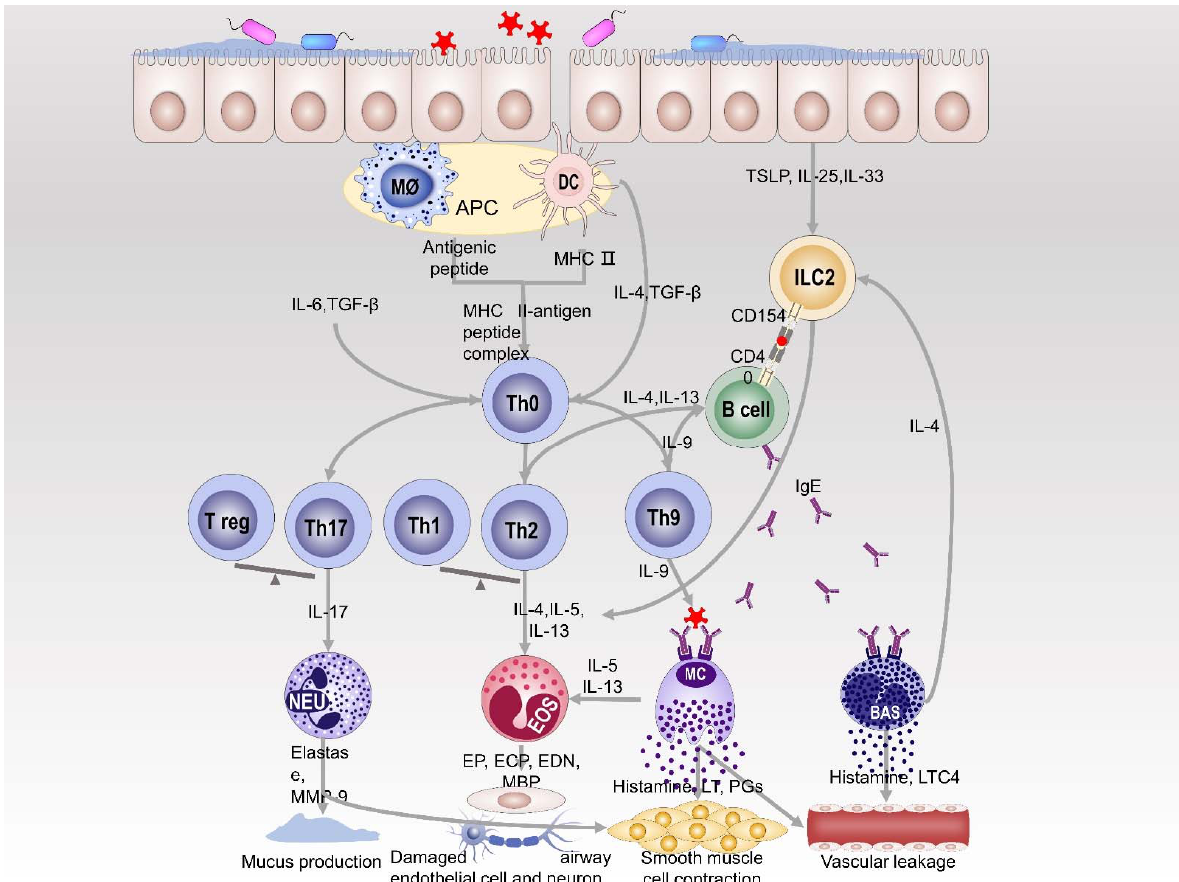
Figure 1. Immune mechanism of allergic respiratory diseases. Allergens are recognized and processed by antigen-presenting cells to form major histocompatibility complex (MHC) class II molecules-antigen peptide complexes that promote the differentiation of T helper (Th) cells into Th2 cells, which product pro-inflammatory cytokines (IL-4, IL-5, IL-13) to activate eosinophils and stimulate IgE synthesis by B cells. Th0 cells are stimulated by different cytokines to differentiate into Th9, Th17 cells and promote the production of IL-9, IL-17. These cytokines activate the corresponding effector cells to produce a variety of active substances leading to immune inflammation. In addition, epithelial cells stimulated by allergens secrete IL-25, IL-33 and thymic stromal lymphopoietin (TSLP) to activate group 2 innate lymphoid cells (ILC2s) that secrete various pro-inflammatory cytokines to act on the corresponding effector cells. Abbreviations: DC, dendritic cells; Mø, macrophages; NEU, neutrophils; EOS, eosinophils; MC, mast cells; BAS, basophils; MMP-9, matrix metalloproteinase-9; EP, eosinophil peroxidase; ECP, eosinophil cationic protein; EDN, eosinophilic neurotoxin; MBP, major basic protein; LT, leukotrienes; PGs,